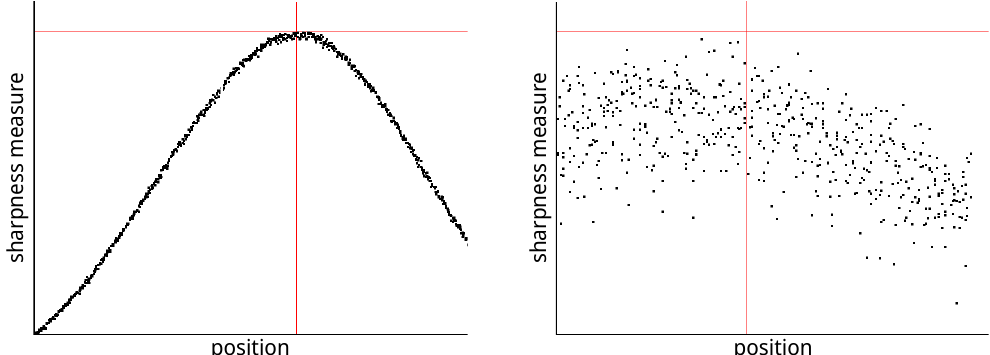
Figure 9. Cruse Focus Value Diagram: graph of sharpness function ( left ), detail of the graph with noise ( right